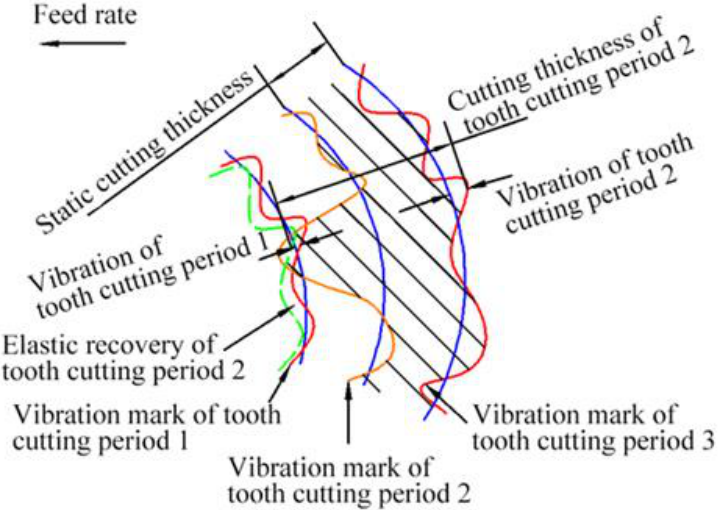
Figure 13. Instantaneous cutting thickness during micro-milling when tooth loses contact with the workpiece in tooth cutting period 2 and immerses in the workpiece in tooth cutting period 1.